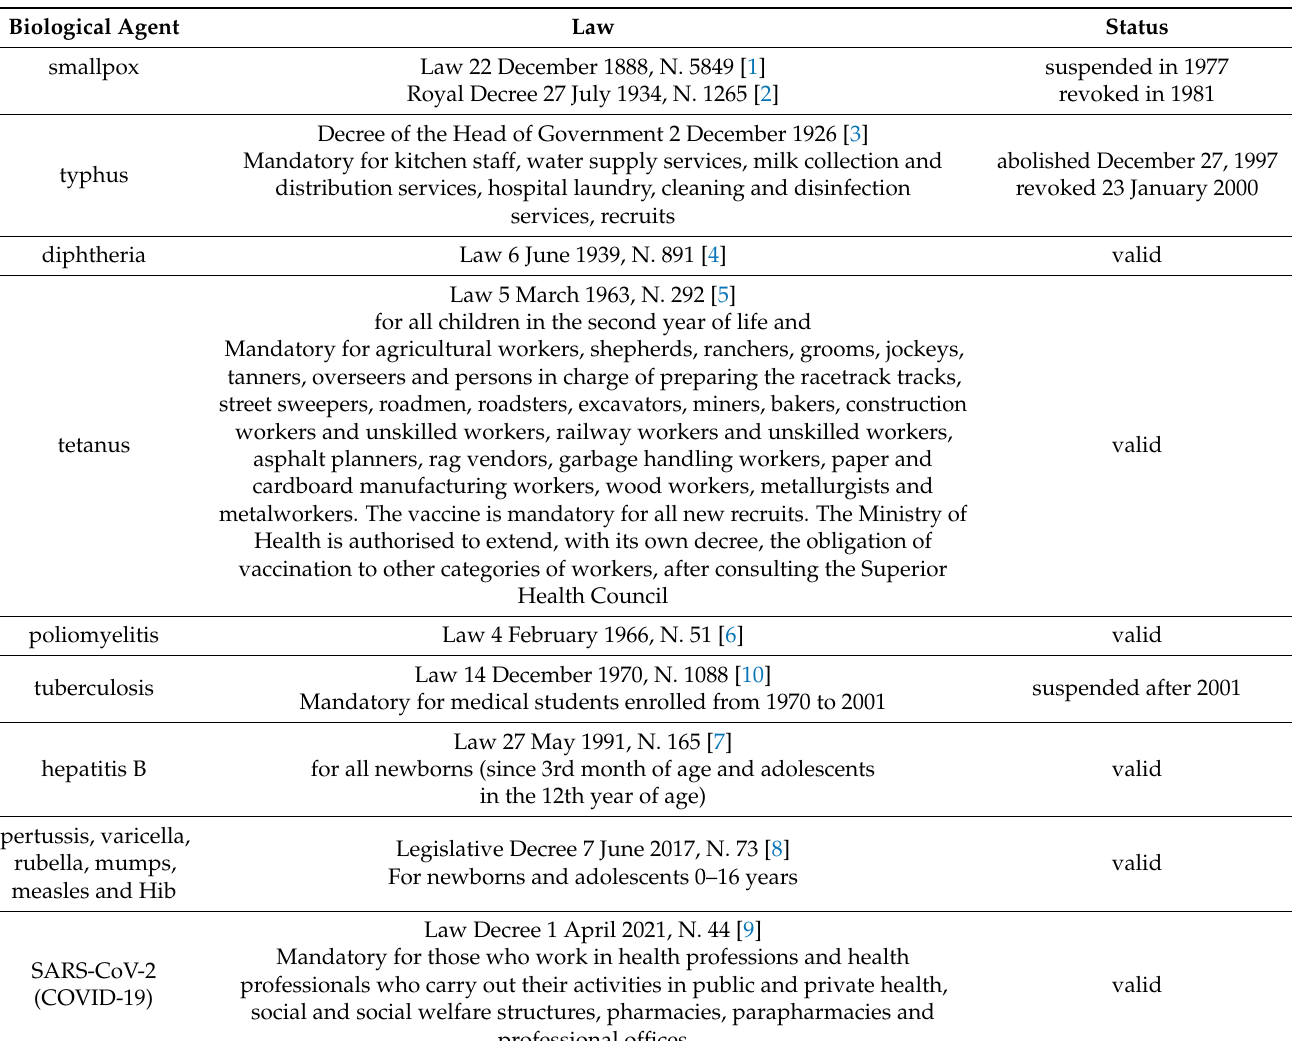
Table 1. History of mandatory vaccination in